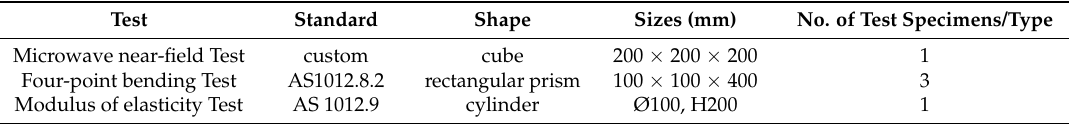
Table 4. Various dimensions of cast ECC